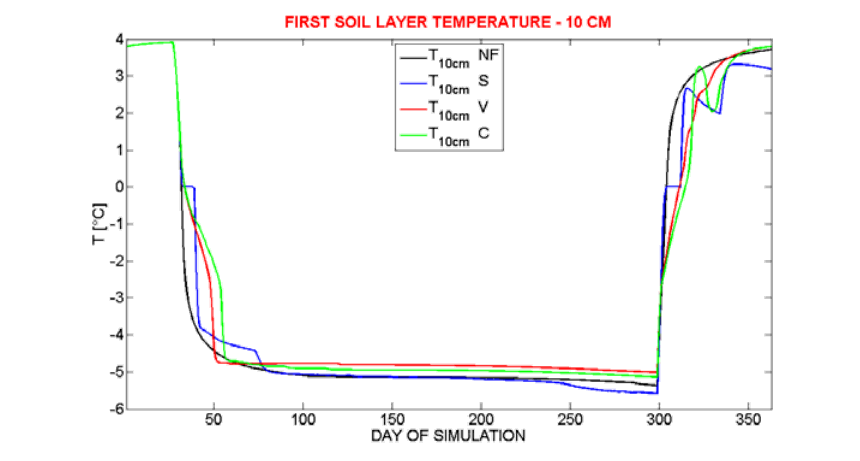
Figure 4. Simulated soil temperature in the 10 cm soil layer.